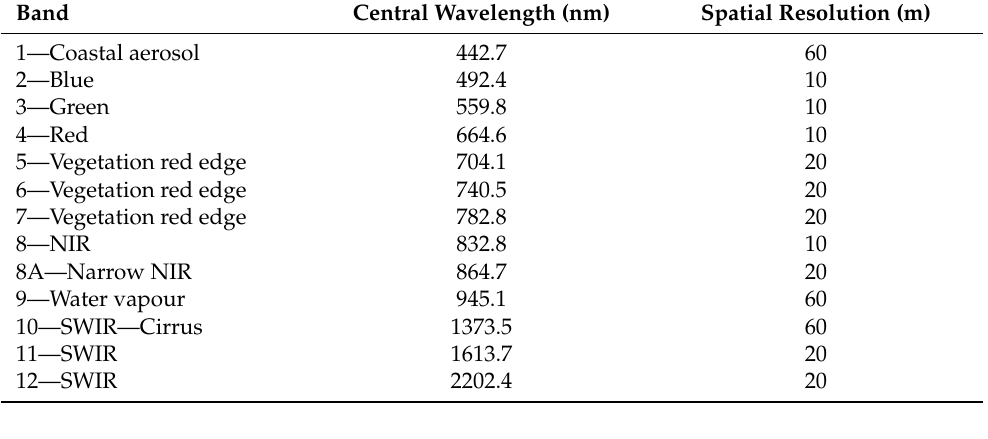
Table 1. Name and central wavelength of the Sentinel-2 spectral bands [1].